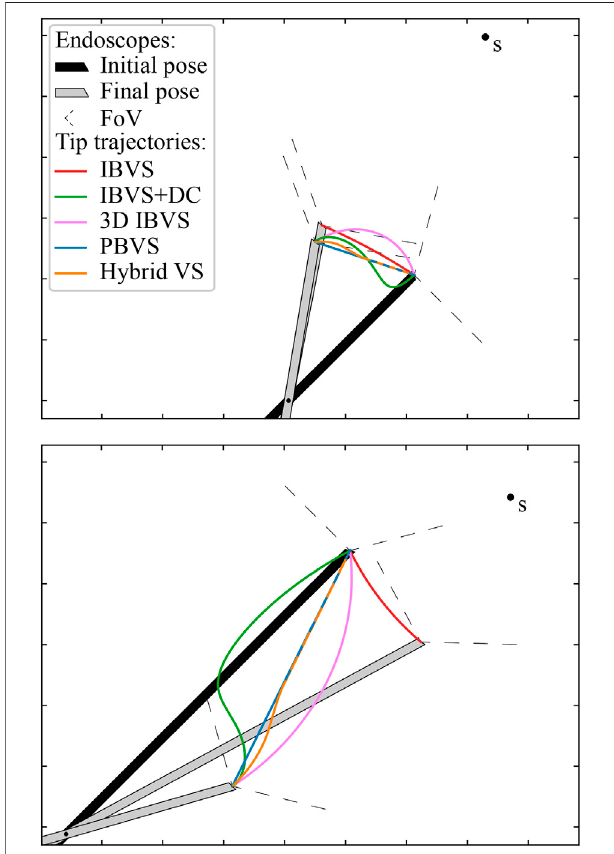
FIGURE 10 | Comparison of the endoscope tip trajectories for different visual servoing approaches for REC. In this simulation, an oblique-viewing 30 ° endoscope with a 120 ° FOV was used. Its initial and fi nal pose are drawn. In the fi nal pose, the feature of interest s is in the desired position with respect to the camera. The trajectories are drawn for a case with a small initial depth error (top) and a large initial depth error